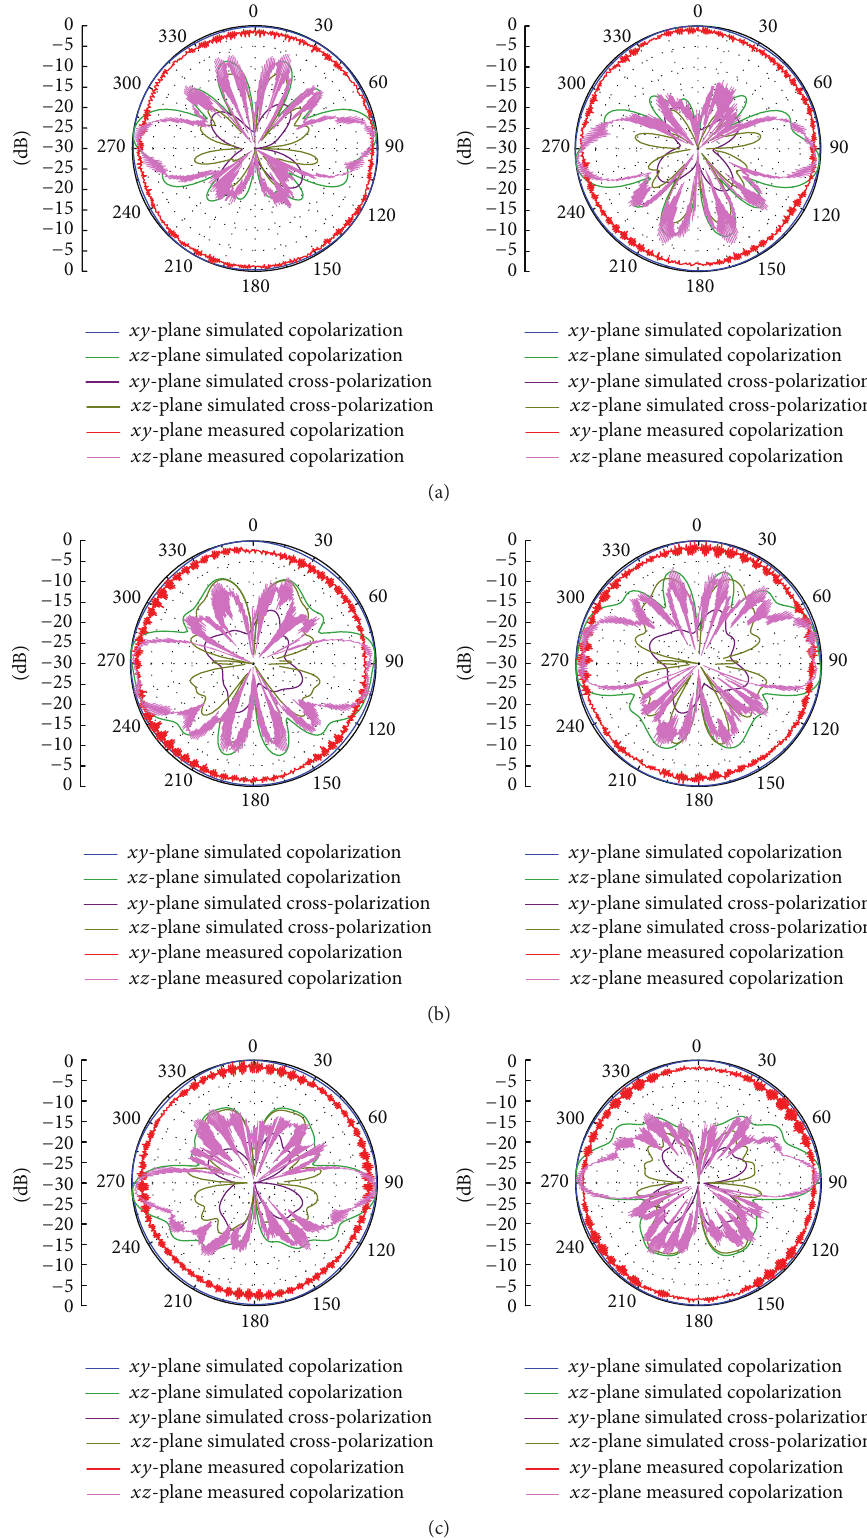
Figure 5: Simulated and measured LHCP (in left) and RHCP (in right) normalized copolarization and cross-polarization radiation patterns in the 𝑥𝑦 -plane (omnidirectional plane) and 𝑥𝑧 -plane. (a) 5.1 GHz, (b) 5.5 GHz, and (c) 5.9